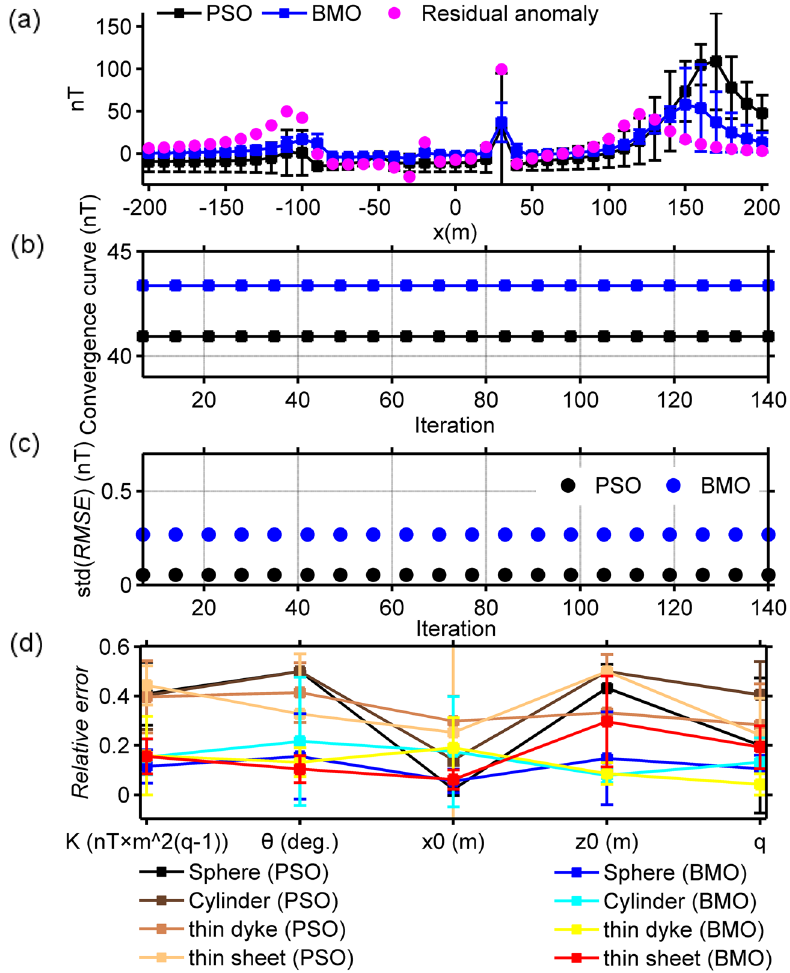
Figure 8. Inversion results of case 2 without the implementation of the SMA technique. ( a ) fittings between the pure residual magnetic anomaly and the responses obtained via BMO and sPSO, ( b ) the variation behavior of the mean RMSE values against iterations after 30 runs, ( c ) the variation behavior of the std of RMSE values against iterations after 30 runs, ( d ) calculated relative errors of model parameter solutions using BMO and sPSO for four causative sources. Error bars are given in ( a ) and ( d